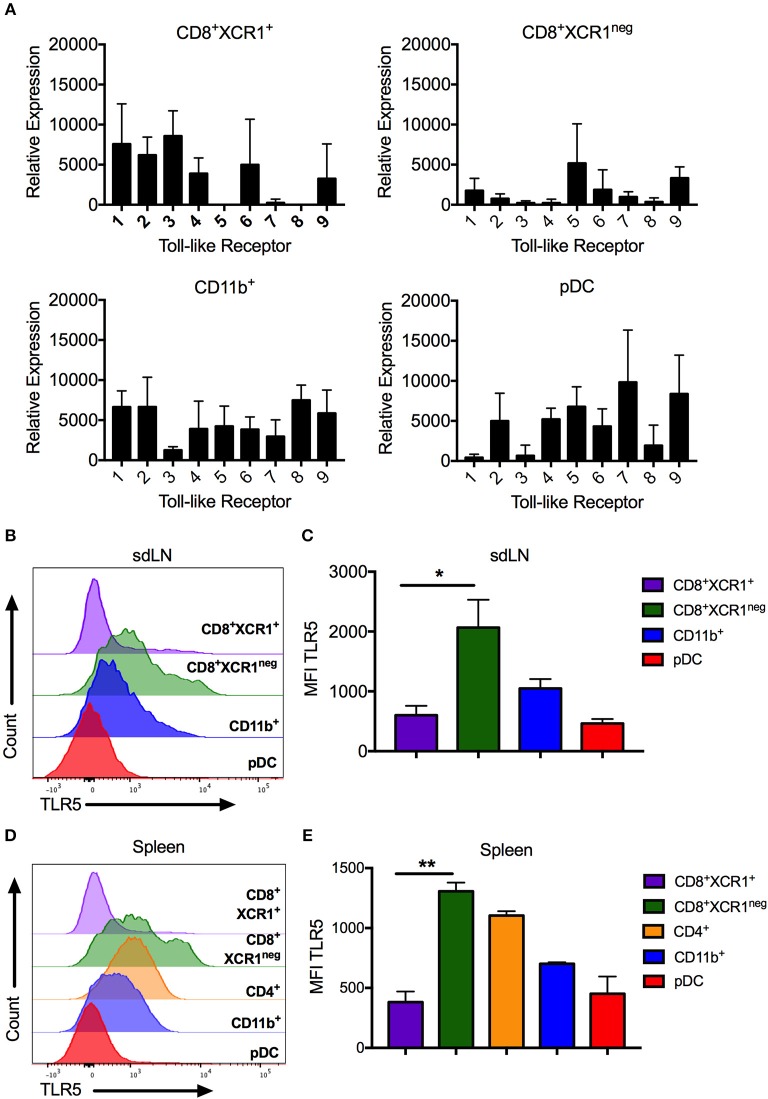
CD8+XCR1neg DCs can be differentiated from CD8+XCR1+ DCs by TLR5 mRNA and cell surface expression. DC subsets were isolated from the sdLN and spleen and their TLR expression was analyzed by RT-PCR or flow cytometry (A) RT-PCR analysis of DC subsets sorted from the sdLNs (Supplementary Figure 1A) and converted to cDNA for use as template in RT-PCR reactions with primers specific to TLRs 1-9. Data are presented as relative expression normalized to GAPDH, n = 3 and error bars represent SEM. DC subsets were isolated from sdLN (B,C) or spleen (D,E) and analyzed by flow cytometry for TLR5 expression. Representative histograms of 4 independent experiments are shown for sdLN (B) and spleen (D). MFI of TLR5 expression on DC subsets from the sdLN (C) or spleen (E) presented as the mean ± the SEM. *p < 0.05, **p < 0.01, n = 4.